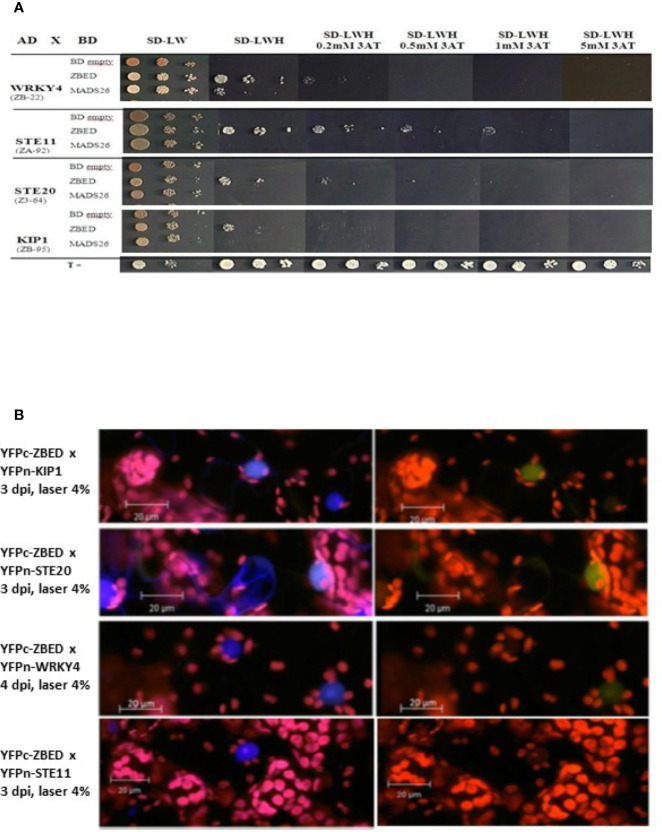
Identification of ZBED-interacting proteins. (A) Screening of two rice yeast two-hybrid cDNA libraries (CO39 and RCL1) with ZBED led to the identification of several putative interacting partners. WRKY4, STE11, STE20, and KIP1 were found to interact with ZBED in yeast cells. Yeasts co-expressing BD-ZBED with either AD-WRKY4, AD-STE11, AD-STE20, or AD-KIP1 were plated on selective media (SD-LWH) with different concentrations of 3AT. Empty pGBKT7-BD (BD-empty) was used as negative bait control. (B) Bimolecular Fluorescent Complementation (BiFC) assay was used to confirm yeast two-hybrid interactions (right panels). Transient co-expression of YFPc-ZBED either with YFPn-KIP1, YFPn-STE20, and YFPn-WRKY4, led to the detection of a nuclear fluorescent signal. Lack of YFP fluorescence upon co-expression of YFPc-ZBED with YFPn-STE11 suggests that these two proteins do not associate in planta. DAPI staining was used for nuclear staining (left panels). Observations were performed on N. benthamiana leaf samples collected three and four days post infiltration (dpi).